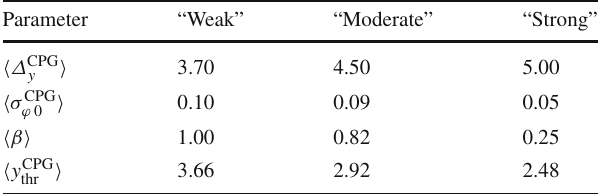
Table 1 Effective parameters of “weak”, “moderate” and “strong” coplanarity versions Parameter “Weak” “Moderate”